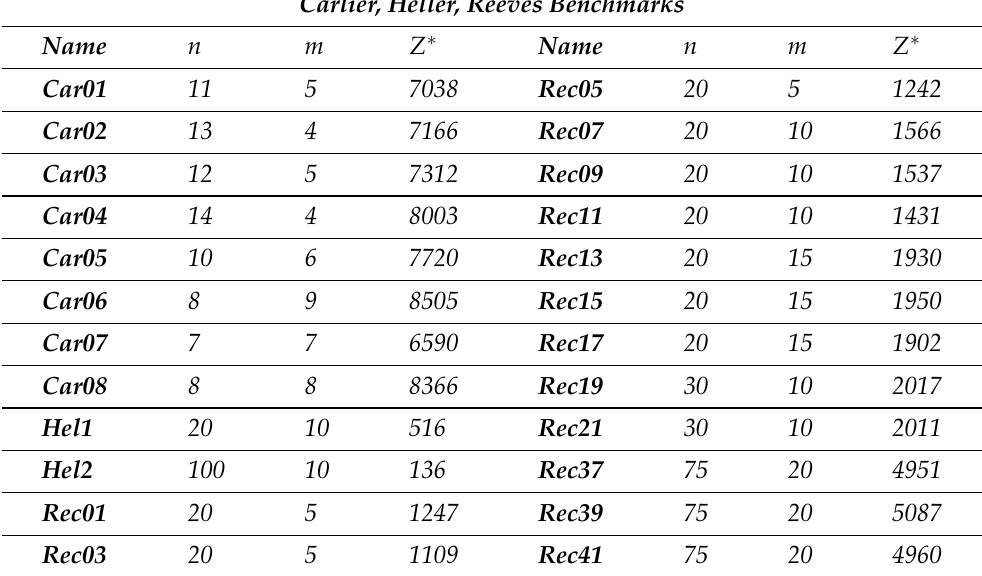
Table 1. The dataset descriptions.